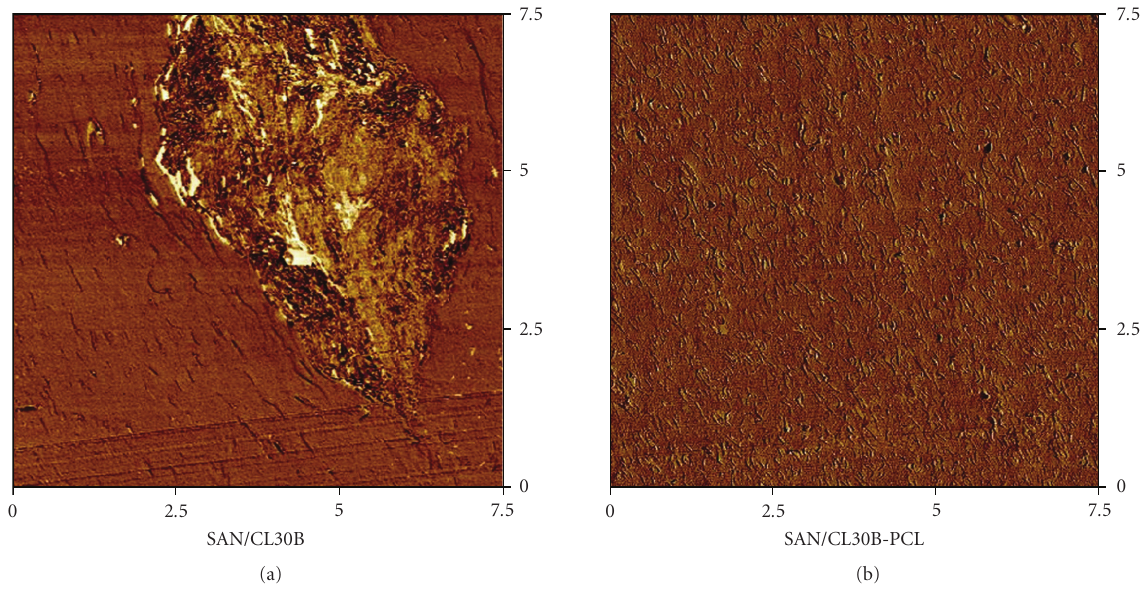
Figure 2: TMAFM phase image of SAN/CL30B and SAN/CL30B-PCL with 3 wt% of inorganics. A clay aggregate ∼ 10 μ m long is seen in the left image. Isolated platelets and small aggregates are only visible when orthogonal to the sample surface; they are seen as thin dark lines.